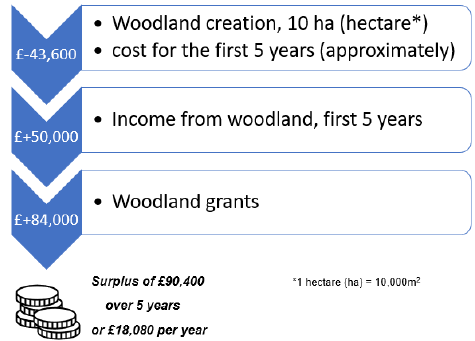
Figure 3. Woodland creation graph.